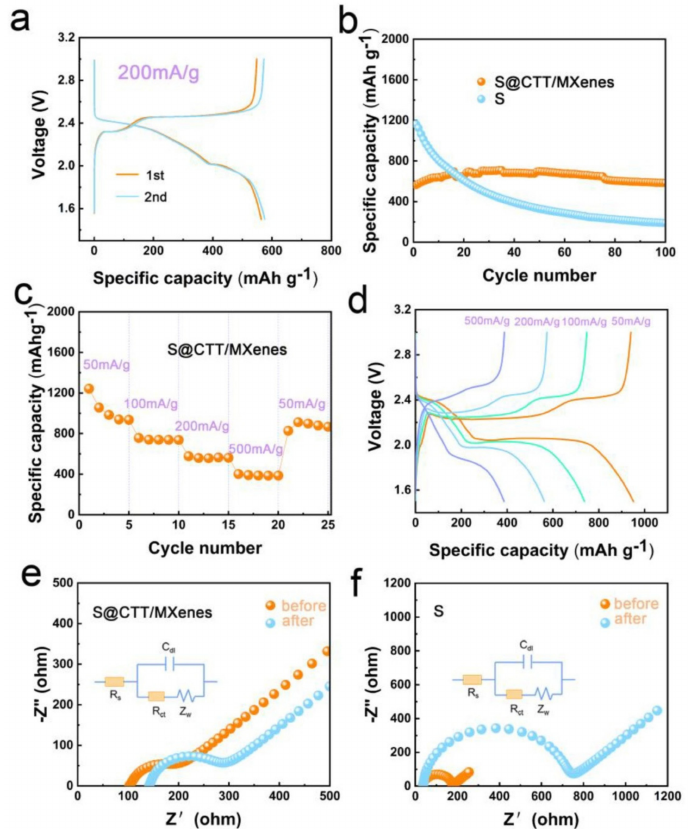
Figure 9. Electrochemical performance of S@CTT/MXene − based electrode. ( a ) CV properties at a condition of 200 mA · g − 1 . ( b ) Specific capacity under different cycling numbers and ( c ) evolution of rate capabilities of S@CTT/MXene. ( d ) The influence of current density, and ( e , f ) EIS performance of S@CTT/MXene − based electrode. Reprinted with permission from Ref. [106]. 2022,